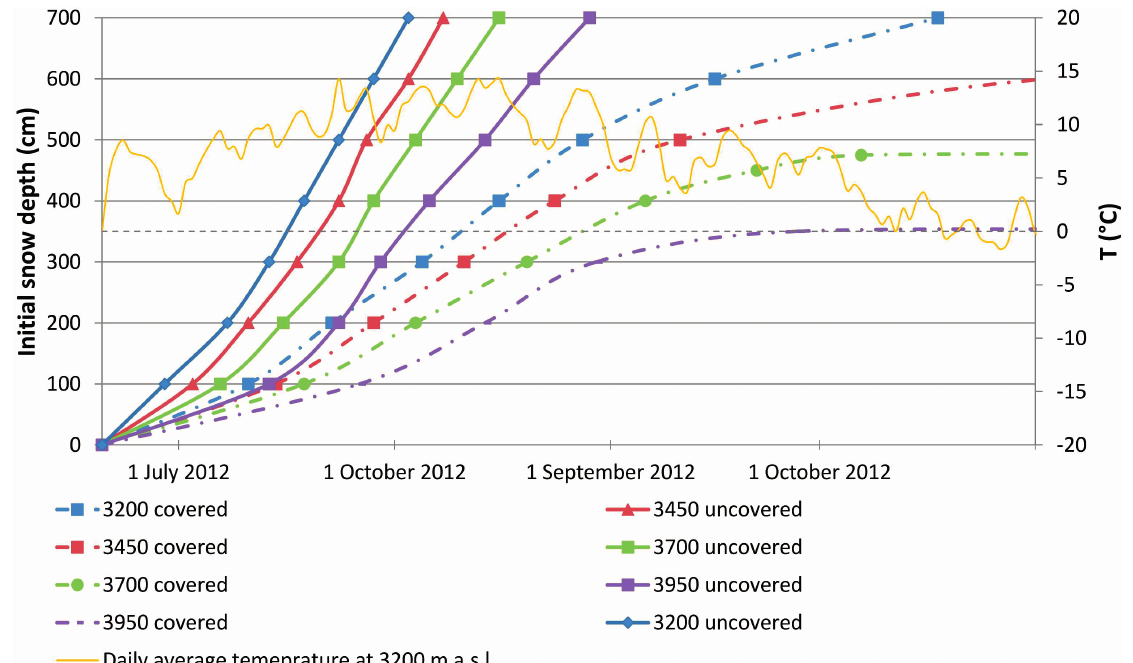
Figure 9. The survival date (symbols) of snow deposits depending on the initial snow depth on four elevation levels integrating the effects of geotextile coverage modeled with the temperature-index